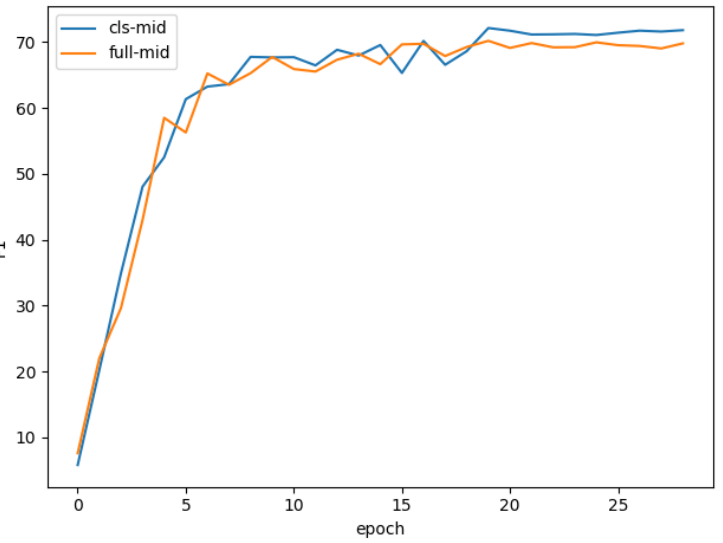
Figure 5. The tendency of F1-scores of two context combination pattern. The cls-mid (blue) performs better than the full-mid